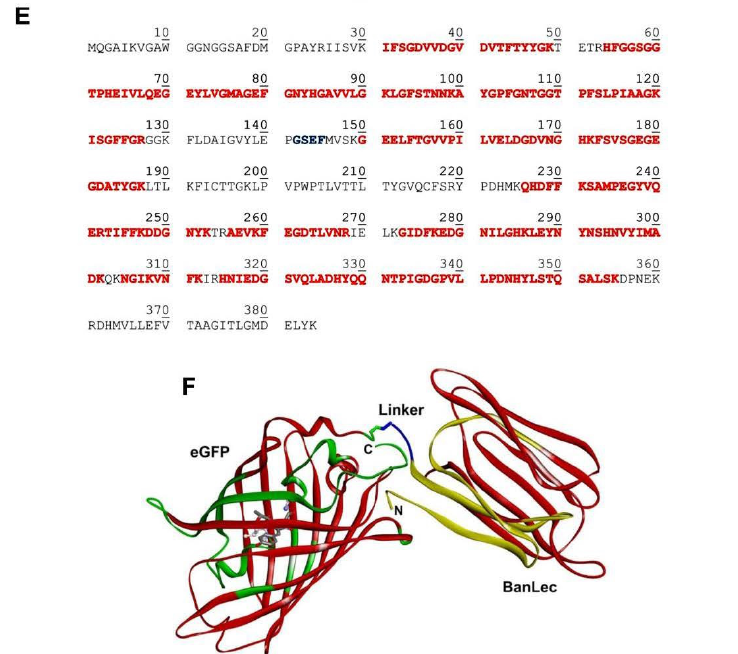
Figure 1. ( A ) The model structure of banana lectin-enhanced green fluorescent protein (BanLec- eGFP) chimera is rendered as a solid ribbon. BanLec is shown in yellow, eGFP in green, glycine- serine-glutamate-phenylalanine (GSEF) linker in blue and carbohydrate-binding sites in pink. The chromophore inside of eGFP is displayed as ball-and-stick. The depiction is made in Discovery Studio 19.1.0 [28]. ( B ) SDS-PAGE represents the profile of expression and purification of BanLec-eGFP (1—cell lysate before the addition of IPTG; 2—cell lysate after overnight expression; 3—BanLec-eGFP after purification; 4—detection of BanLec-eGFP by the polyclonal rabbit anti-rBanLec antibodies; MW, molecular weight marker). ( C ) Fluorescence spectra of BanLec-eGFP chimera. ( D ) Circular dichroism (CD) spectra of BanLec-eGFP in the far-ultraviolet region (185–260 nm). ( E ) The amino acid sequence of BanLec-eGFP chimera. The amino acid residues marked in red color represent the tryptic peptides that have been experimentally confirmed by the MS analysis. The linker GSEF is marked in blue. The theoretical pI = 5.66 and Mw = 41,925.32 Da for the BanLec-eGFP chimera. ( F ) The model structure of the BanLec-eGFP construct was rendered in ribbon representation. The fragments of the structure experimentally confirmed are shown in red, while the other parts of BanLec, linker, and eGFP are displayed in yellow, blue, and green, respectively. The chromophore is shown in stick rendering in a gray color. The depiction was made in Discovery Studio